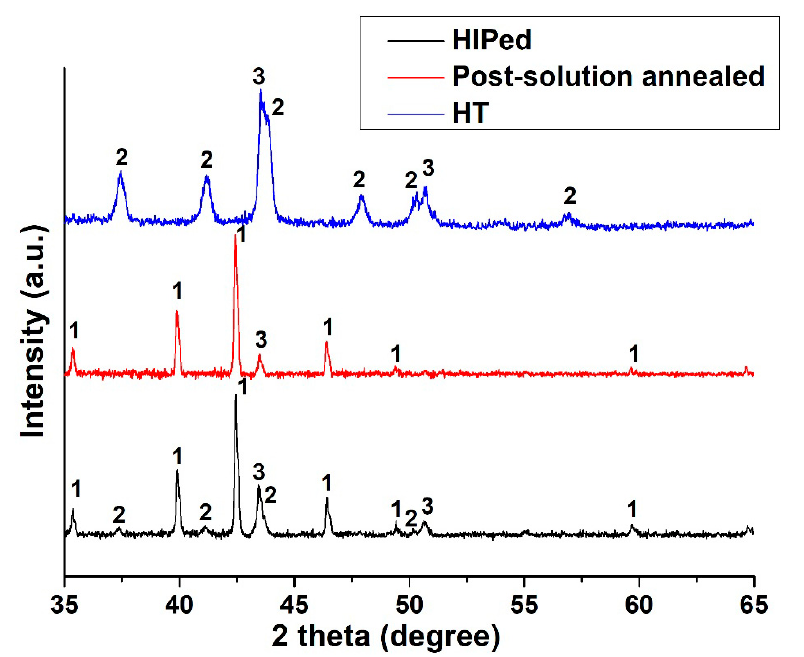
Figure 7. X-ray diffraction (XRD) patterns of extracted carbides from HIPed, post-solution annealed, and HT HX materials. 1 = Mo-rich M 6 C carbides, 2 = Cr-rich M 23 C 6 carbides, 3 = γ -fcc